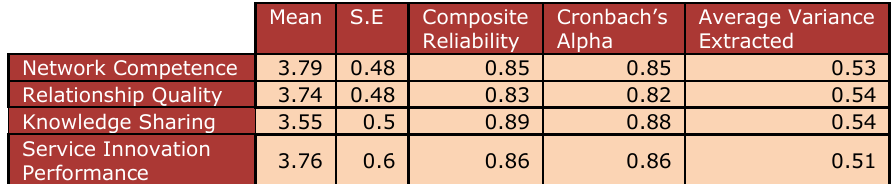
Table 1. Means, S.E, CR, Cronbach’s Alpha ,